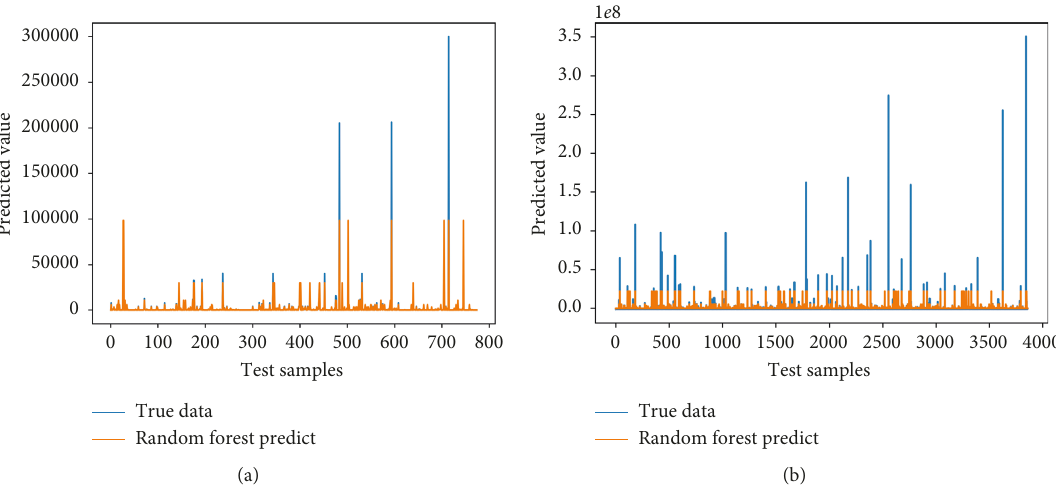
Figure 9: Testing performance of random forest regression on (a) UCI seismic bumps and (b) AAIA ′ 16 seismic.